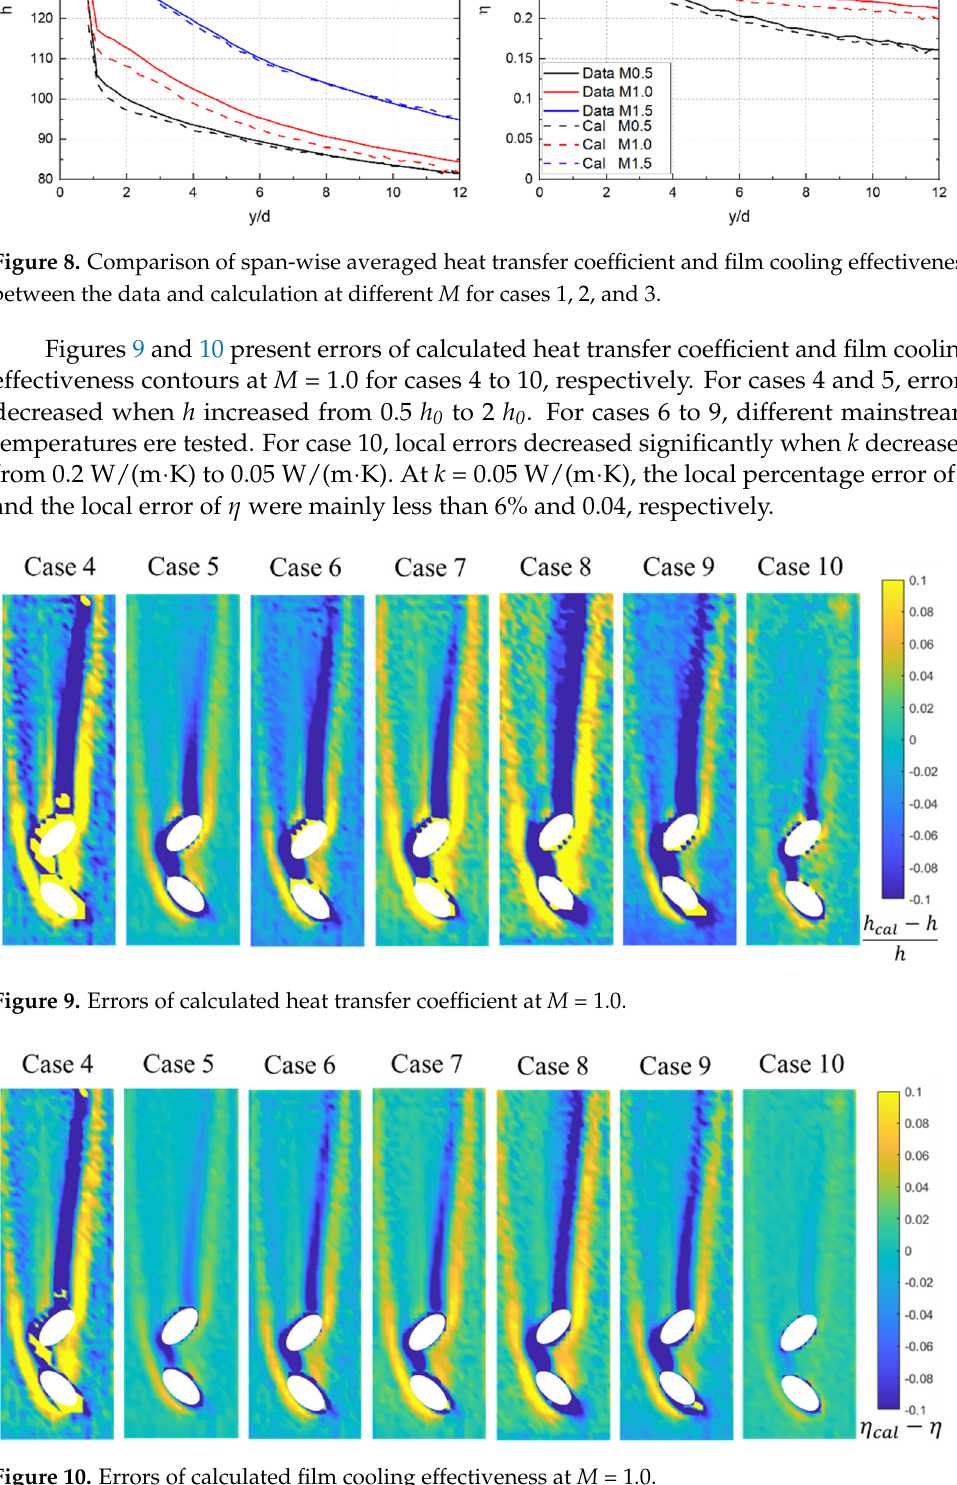
Figure 7. Comparison of heat transfer coefficient and film cooling effectiveness between the data and calculation at different M and y/d .